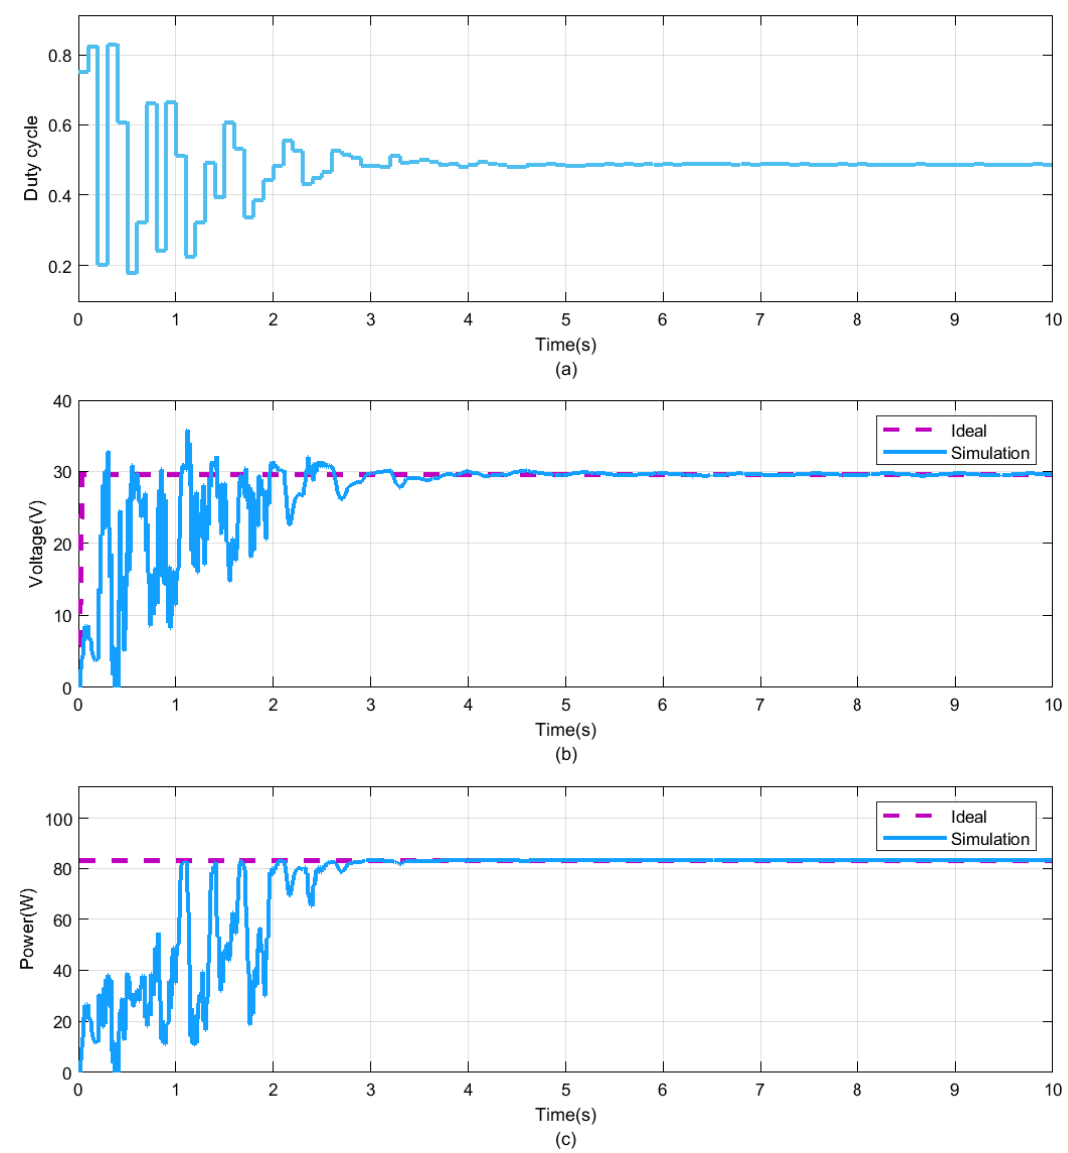
Figure 7. Simulation results under G = 800 W/m 2 , Tc = 48 ◦ C and Np = 6 given by the Improved Particle Swarm Optimisation (IPSO) algorithm: ( a ) Duty cycle, ( b ) Voltage, and ( c )